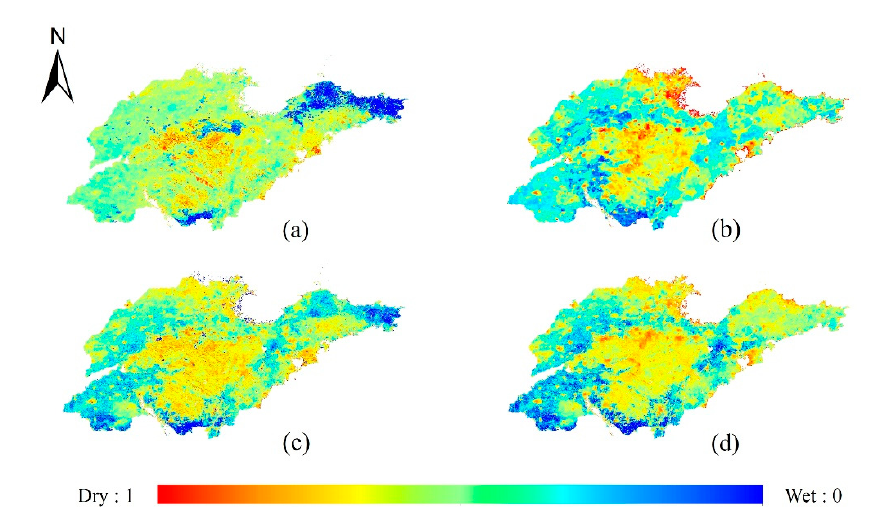
Figure 10. The results of drought monitoring in January in Shandong Province, China. All maps were normalized, and the spatial resolution of these maps is 1 km. ( a ) SM calculated using the NIR-Red spectral space, ( b ) downscaling results of FY3B SM, ( c ) TVMDI and ( d ) iTVMDI.